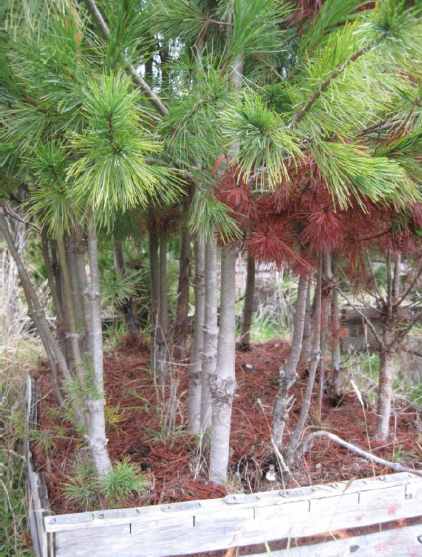
Figure 4. Survival differences (five years after artificial inoculation) among susceptible western white pine family and several other seedlots in a trial at Dorena Genetic Resource Center (GRC). Family ―75‖ on left adjacent to ―79‖ (all dead and removed (see missing row in line with third metal tag from the left)) in 10 tree row plots (see Table 1 for rust resistance information on Families ―75‖ and